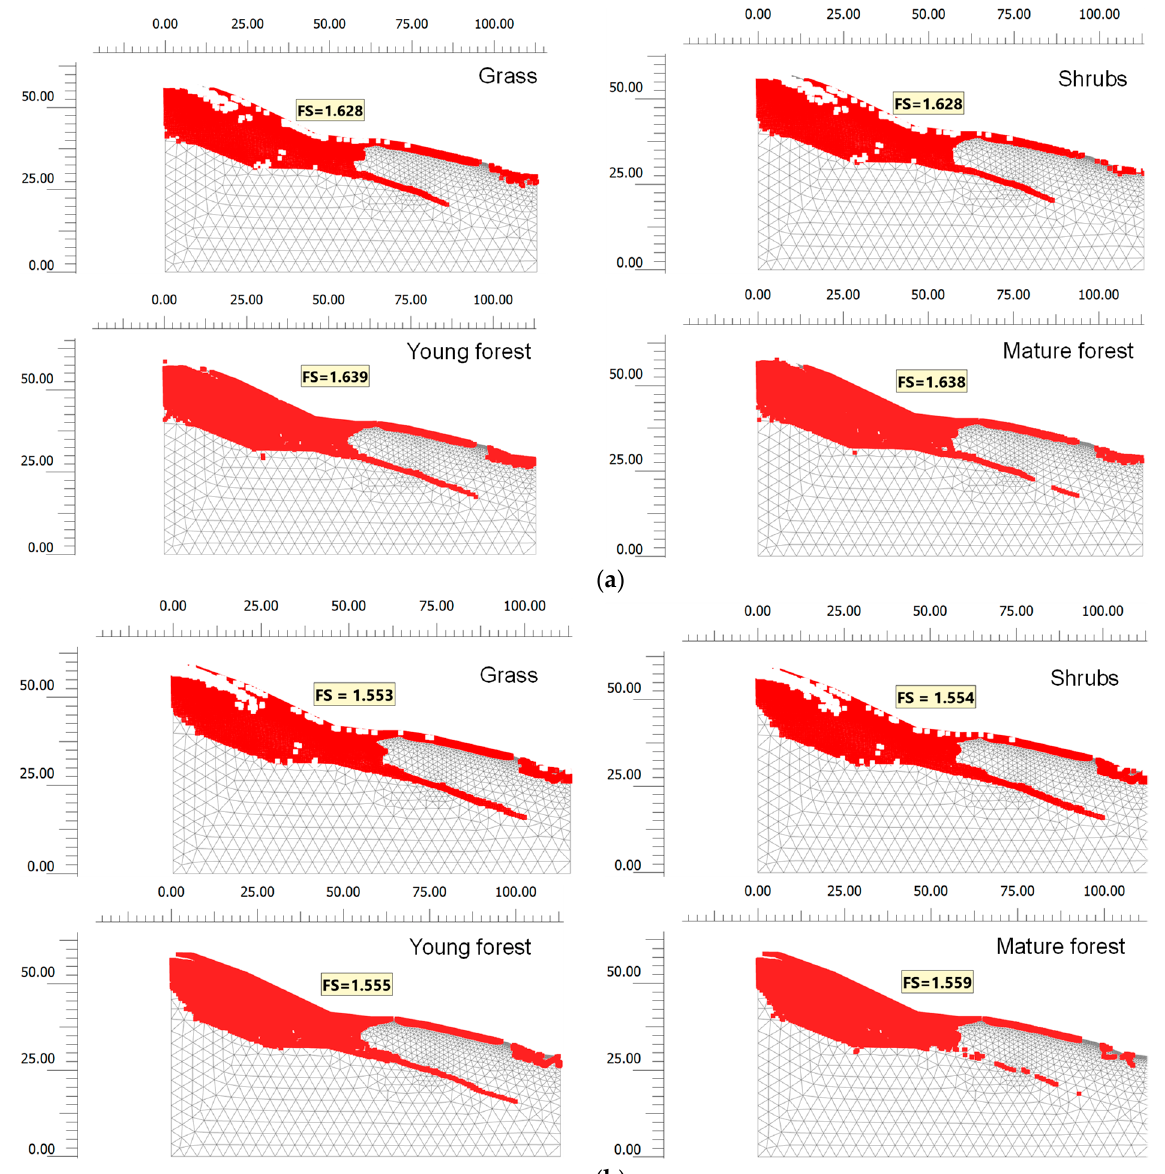
Figure 7. Comparison of the four type of vegetation on reinforcement of the slope: ( a ) using average soil strength parameters; ( b ) using minimum soil strength parameters. Note: the red and white points denote the plastic point and tension cut-off point of the slope during the calculation of the factor of safety.